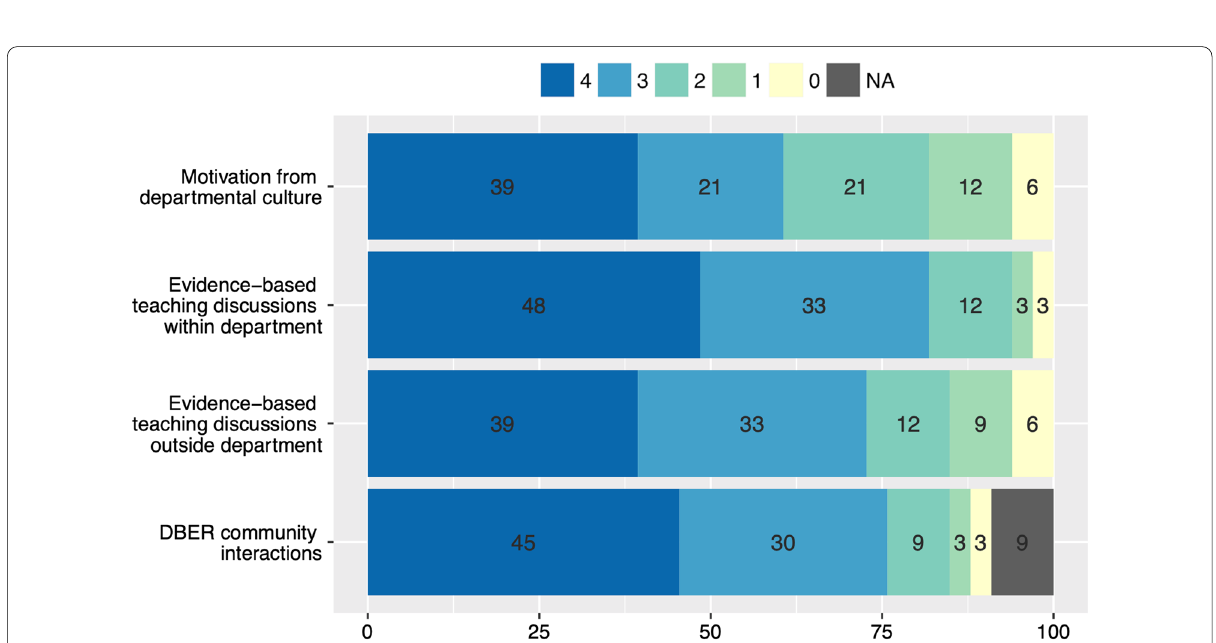
Fig. 5 Community. Percent of Faculty Scholars reporting their level of engagement with departmental and institutional faculty communities. Faculty responses were recorded on an anchored 5-point rating scale, with rating 4 indicating highest importance (i.e., “very much so”) and rating 0 indicating lowest agreement (i.e., “not at all”). Numbers superimposed in the bars are the percentage of respondents choosing that option ( N